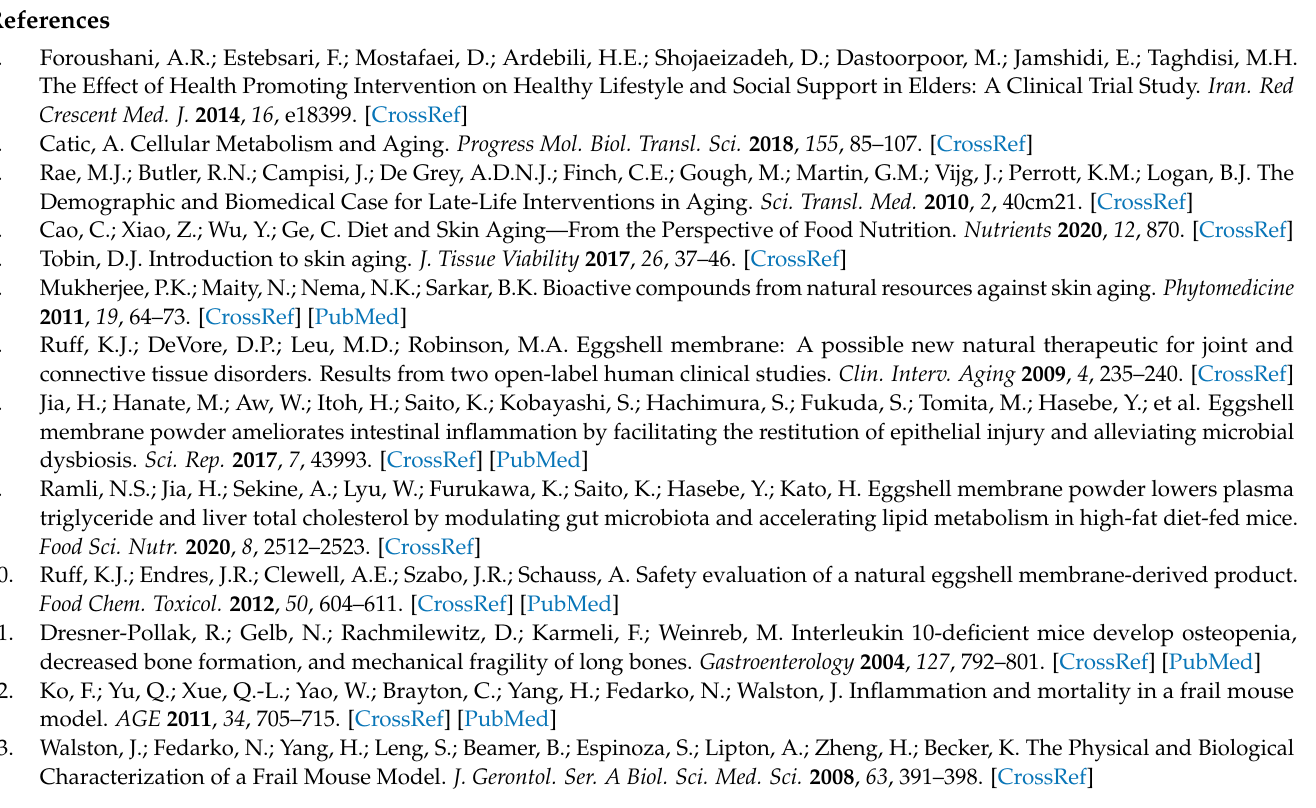
Table S3: Major gene list of “Growth of epithelial